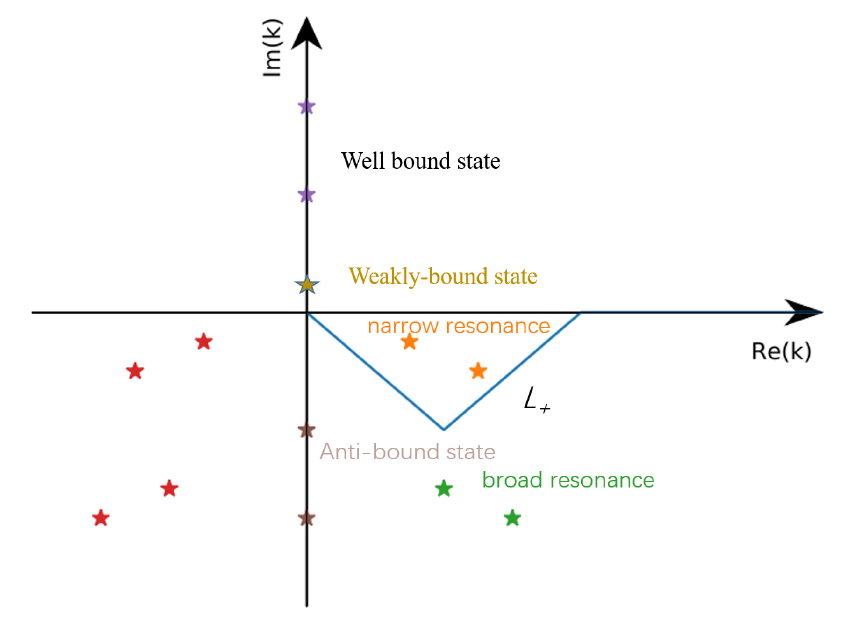
Figure 1. Depiction of the Berggren basis in the complex-momentum- k plane for a fixed partial wave. Typical complex momenta of bound, narrow, and broad-resonance states, i.e., S -matrix pole, are provided. The L + contour of scattering states encompasses the S -matrix poles of